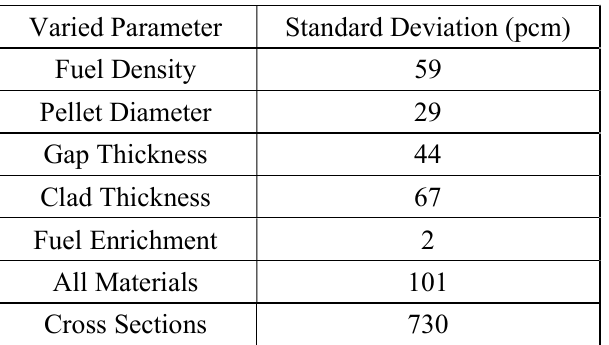
Table VI. Material parameter uncertainty quantification: Standard deviation of the effective neutron multiplication factor when varying certain